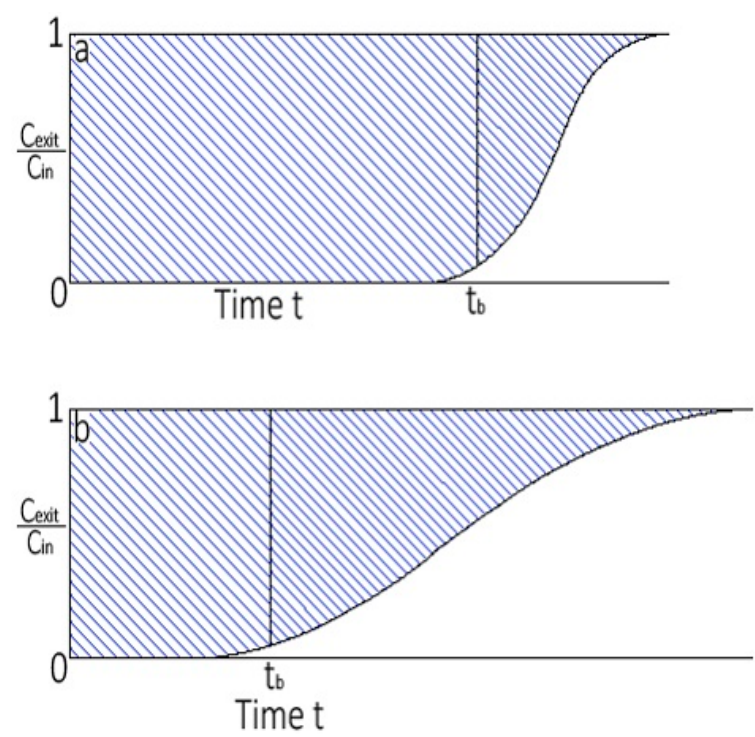
Figure 10. ( a ) Breakthrough profile and narrow MTZ , and ( b ) breakthrough profile and wide MTZ .